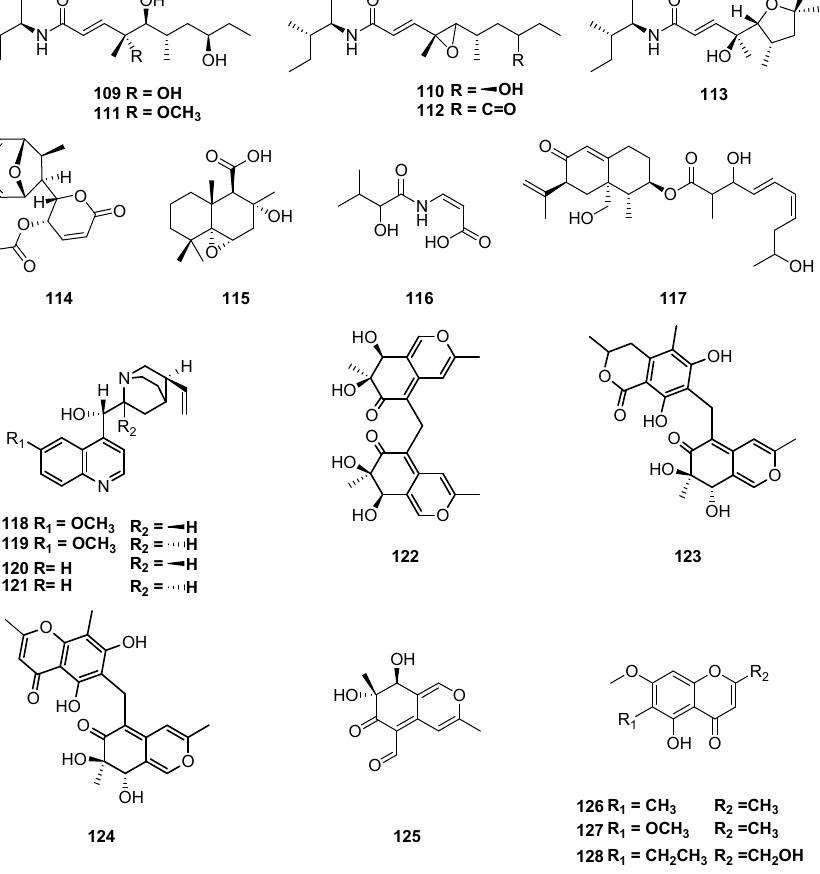
Figure 10 . Compounds extracted from endophytic fungi, Curvularia geniculate , D. pseudomangiferae , Diaporthe, Colletotrichum spp and Mycoleptodiscus indicus obtained from Catunaregam tomentosa , Sabicea cinereal, Cinchona ledgeriana, C. calisaya and Borreria verticillate, respectively . A fungus endophyte from Uncaria rhynchophylla , C. gloeosporioides (Glomerellaceae), produced